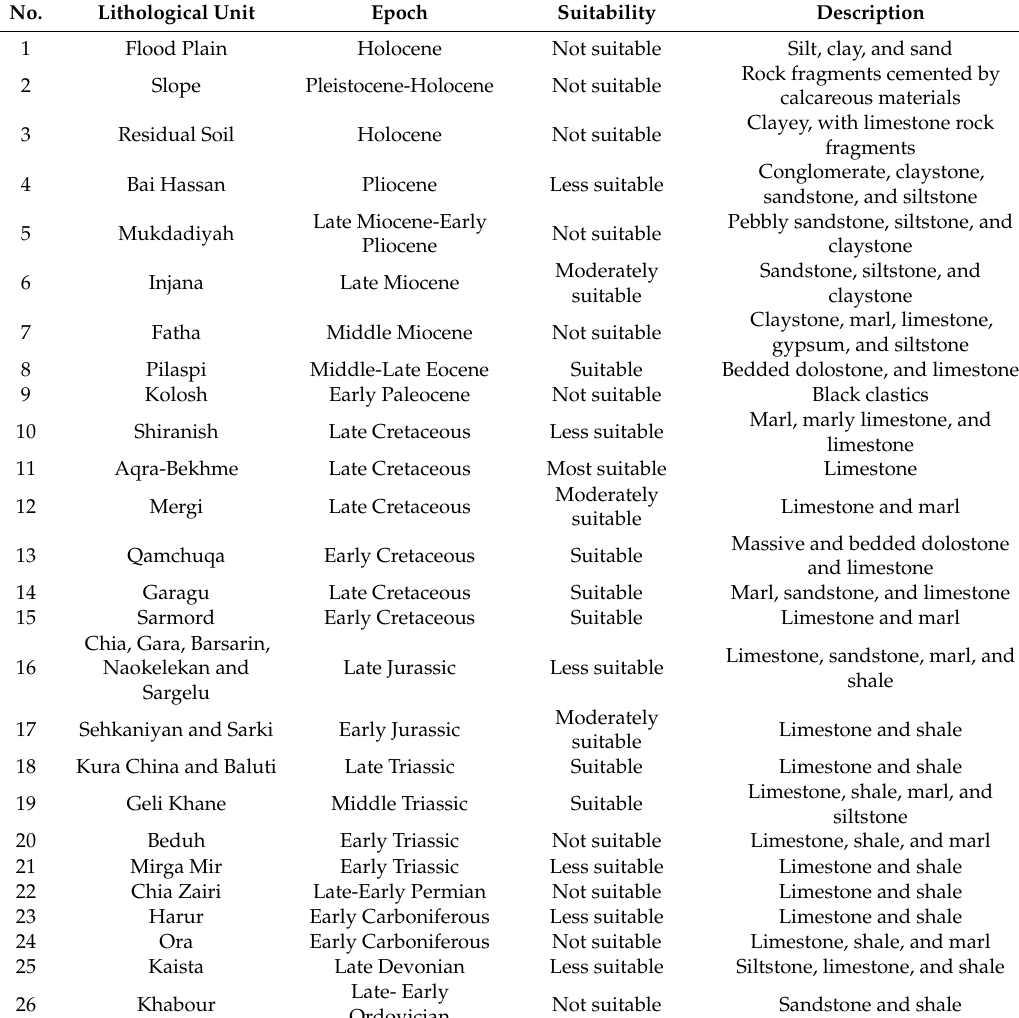
Table 2. Brief descriptions of geological formations and lithological units in the study